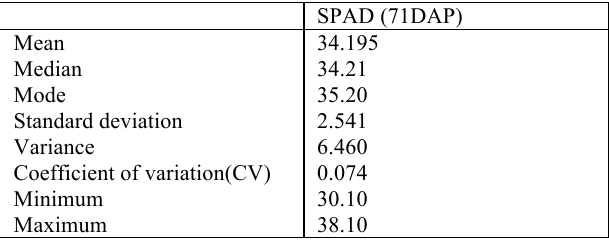
Table2: Descriptive statistics for SPAD reading in 71DAP